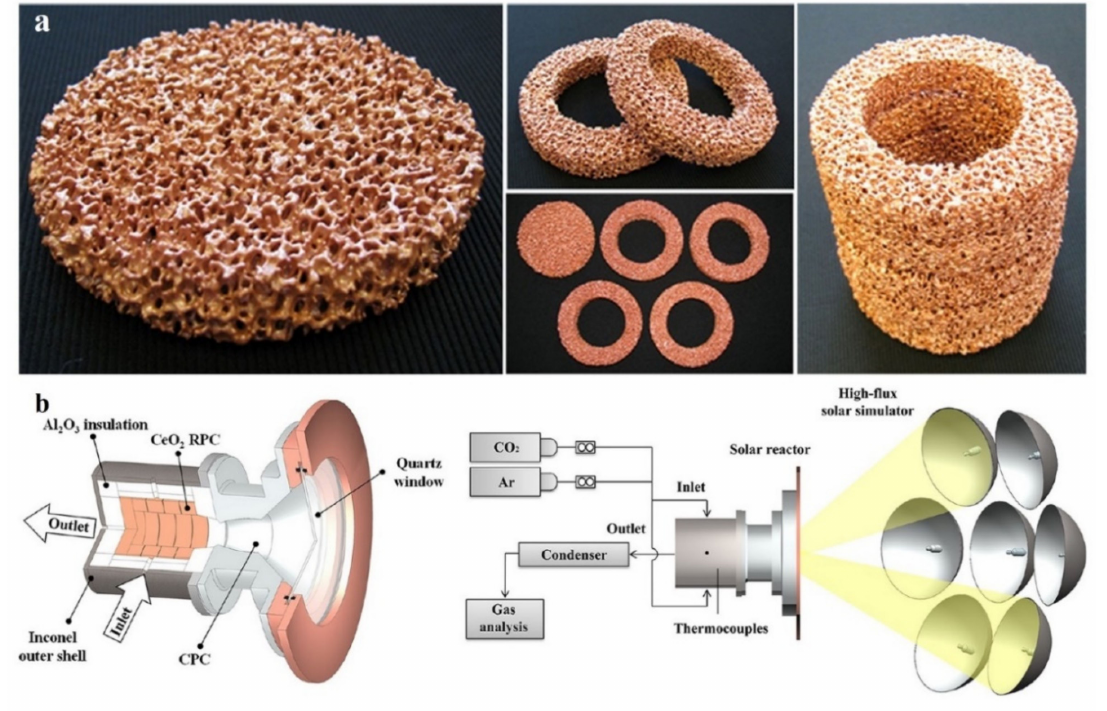
Figure 9. ( a ) Ceria-coated RPCs consisting of a 20-mm thickness, 100-mm o.d. disk, and four 20-mm thicknesses, 60-mm i.d., 100-mm o.d. rings; ( b ) High-Flux Solar Simulator and the configuration of porous modules’ assembly at the Swiss Federal Institute of Technology (ETH) (bottom) [114]. The novel configuration of ceria RPCs with dual scale porosity, i.e., larger macropores, between struts and smaller µ m-sized pores inside struts, was also examined [118]. In doing so, some ceria foams were manufactured with pore sizes in the millimeter range (d mean = 2.5 mm and ε = 0.76–0.82) macroscopically through the bulk and micrometer order (d mean = 10 µ m and ε strut = 0–0.44) inside the struts by using some sacrificial carbon- based pore-forming agent with particle sizes of 0.4–12 µ m. The synthesized dual-scale ceria foam is shown in Figure 10. Thermogravimetric experiments (TR: 1500 ◦ C and CDS: 600–1000 ◦ C) revealed a 10 times’ higher yield for the samples with porous struts (porosity: 0.44) compared to samples with non-porous solid struts. It was